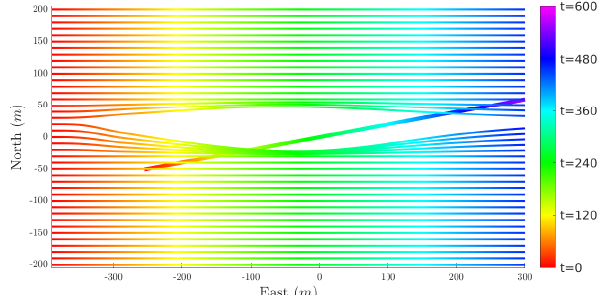
Figure 12: Batch 4: Overtaking.